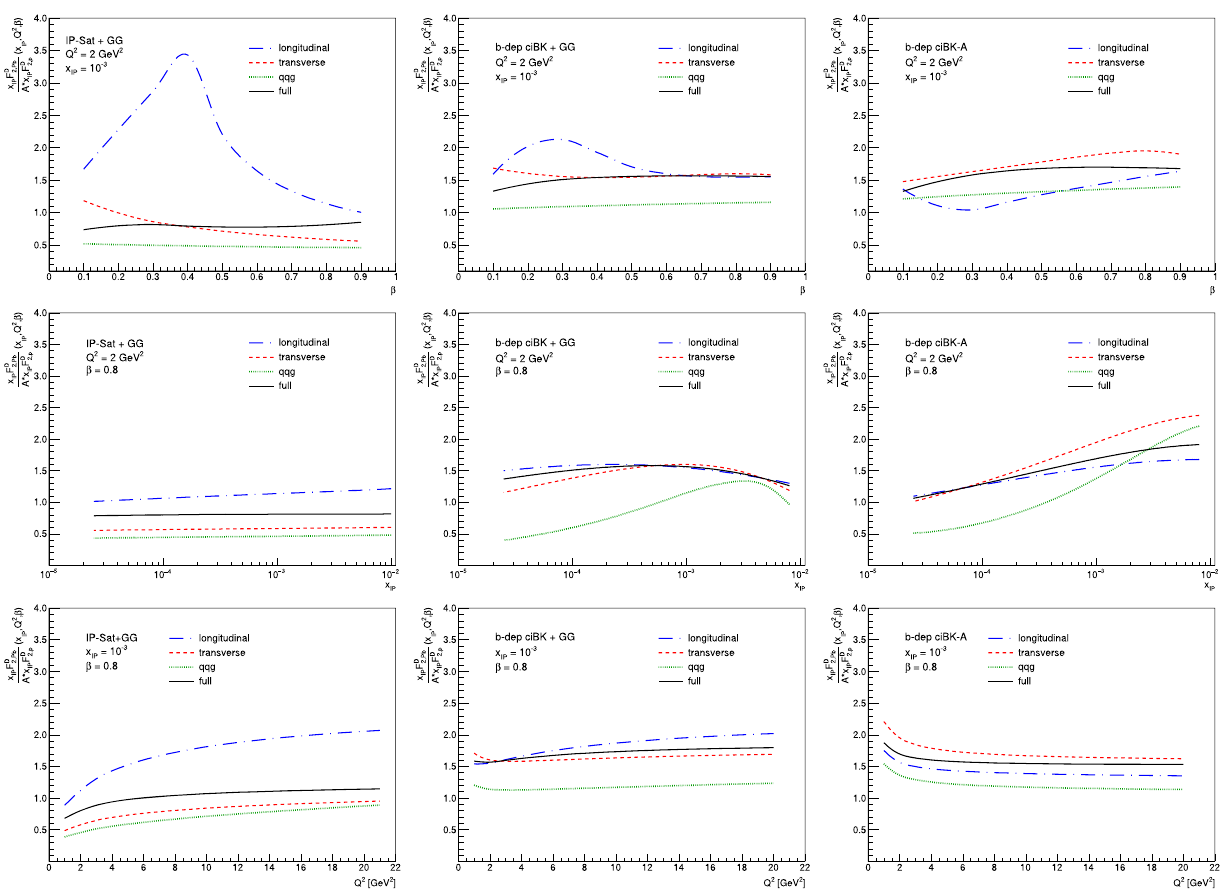
Fig. 9 Predictions for the β , x IP , and Q 2 dependencies (from top to bottom, respectively) of the ratio F D sideringtheIP-Sat+GG(leftpanels),b-depciBK+GG(middlepanels)